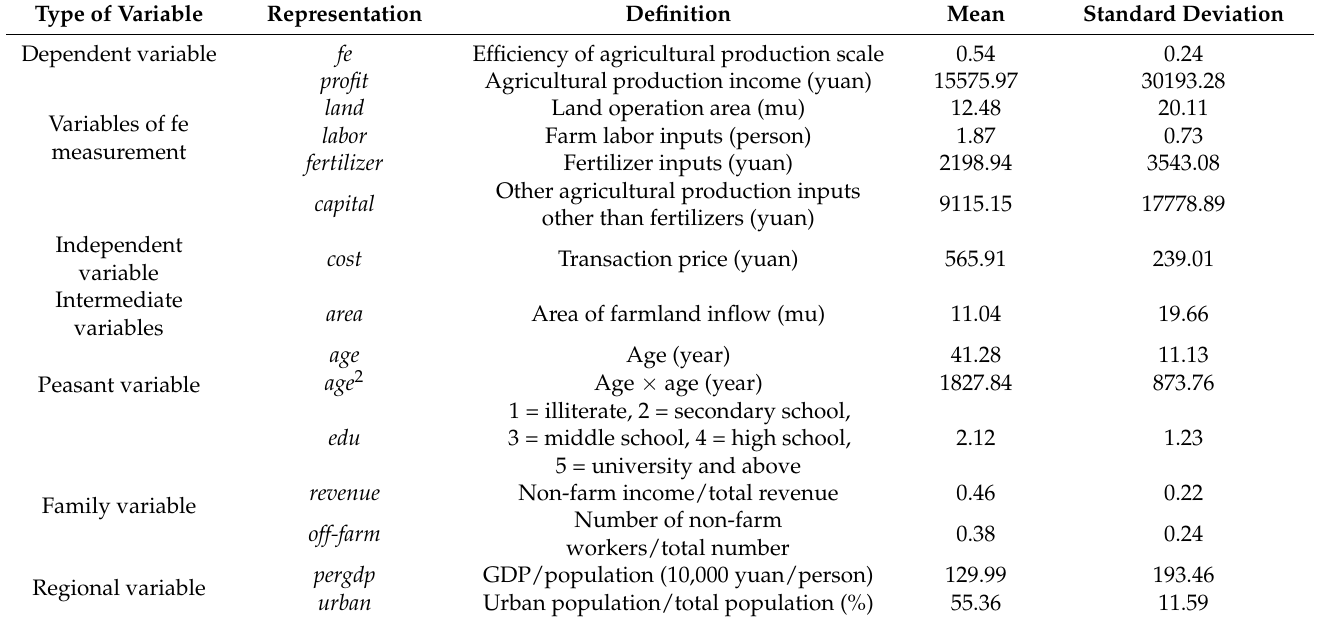
Table 1. Descriptive statistics of